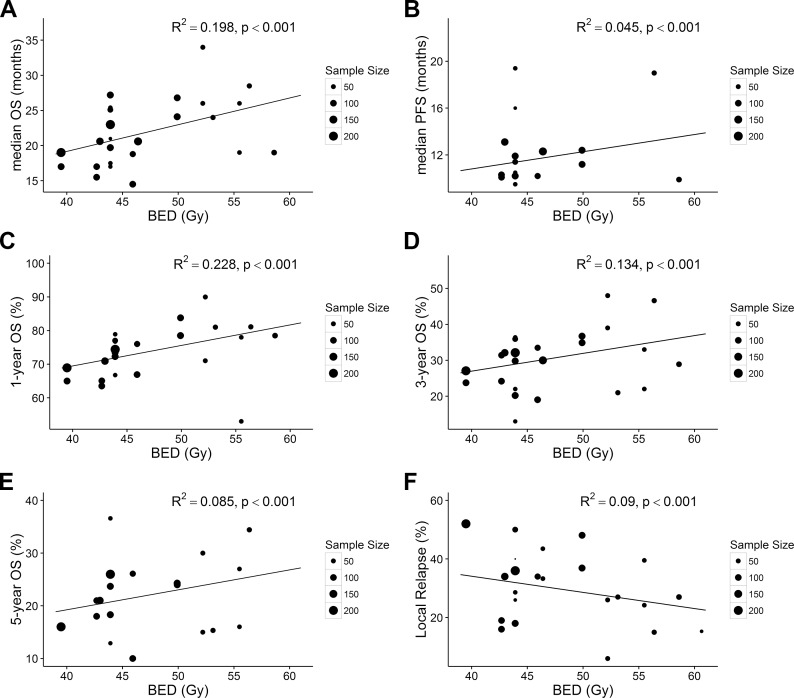
Association between BED and mOS (A), mPFS (B), 1-year OS (C), 3-year OS (D), 5-year OS (E), and LR (F) for all included studies. Each point in the plot represents a value of one arm. The point size represents the sample size. All analyses were conducted by linear regression methods weighted by sample size. BED, biological effective dose; mOS, median overall survival; 1-, 3-, 5-year OS, 1-, 3, 5-year overall survival; LR, local relapse